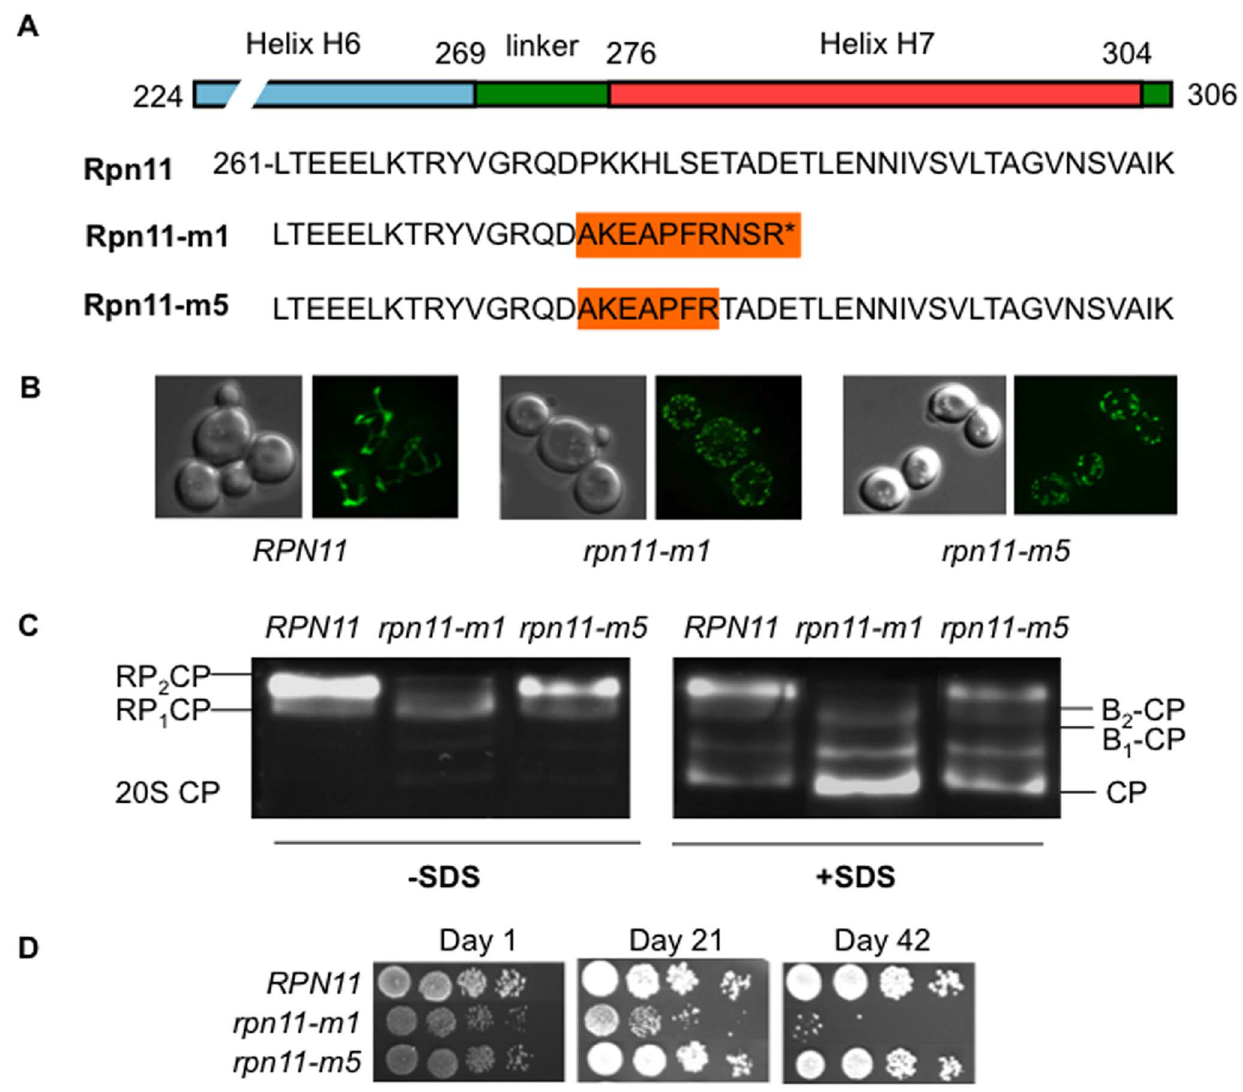
Figure 1. Phenotypes of the rpn11-m1 and rpn11-m5 mutant strains. ( A ) Alignment of the carboxyl amino acid sequences of Rpn11, Rpn11- m1 and Rpn11-m5. The amino acid changes are in orange. ( B ) Wild type (W303-1B background), rpn11-m1 and rpn11-m5 cells expressing mtGFP were grown to log phase in glucose containing medium (YPD) and examined by fluorescence (right) and phase contrast (left) microscopy. ( C ) Cell extracts prepared from exponentially growing wild type, rpn11-m1 or rpn11-m5 strains, brought to an identical cell density at the permissive temperature of 26 u C were clarified by centrifugation, and samples containing identical amounts of total protein were separated by non-denaturing PAGE (native gels). Proteasomes were visualized by the fluorogenic peptide overlay assay. Proteasome holoenzymes in WT and rpn11-m5 are found as a mixture of symmetric doubly capped (RP2CP) and asymmetric singly capped (RP1CP) conformations. 26S proteasomes in rpn11-m1 are found almost exclusively in lidless forms (B2-CP or B1-CP). 20S CP is visualized upon activation of the CP by 0.05% SDS (right panel). Higher levels of dissociated free 20S CP are evident in rpn11-m1 and more discrete for rpn11-m5 . ( D ) Survival during starvation-induced stationary phase of wild type, rpn11-m1 and rpn11-m5 strains on glucose containing rich medium (YPD) at 26 u C after growth for 1, 21 and 42 days. Comparable number of cells was spotted at 10-fold dilutions on YPD medium.